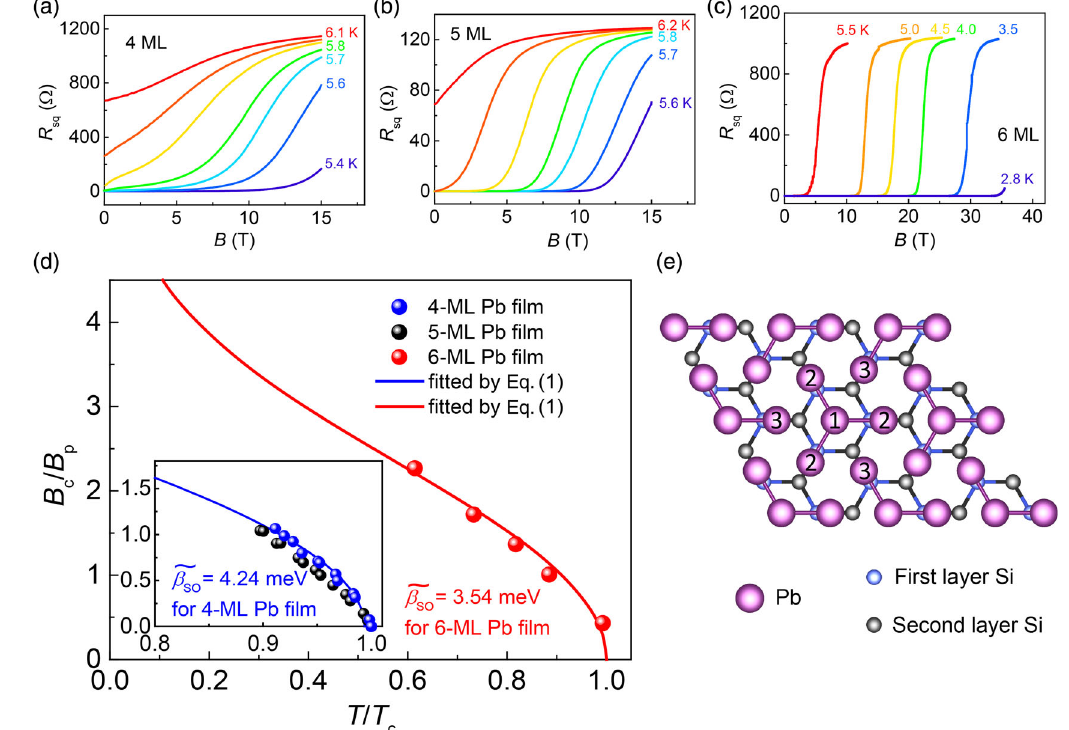
FIG. 3. Experimental evidence for Zeeman-protected superconductivity in ultrathin (4 – 6-ML) Pb films. (a) – (c) Parallel magnetic field dependence of R at various temperatures for (a) 4-ML (sample 1), (b) 5-ML (sample 2), and (c) 6-ML (sample 3) Pb films. At 2.8 K or sq lower temperatures, superconductivity survives under high magnetic fields up to 35.5 T for 6-ML Pb film. (d) B c normalized by Pauli limit B p as a function of reduced temperature T=T c for 6-ML Pb film. Here, B c is determined as the magnetic field required to reach 50% of normal-state sheet resistance R n . The measured B c can be well fitted by the theoretical curve for Zeeman-protected superconductivity ¼ 3 . 54 meV in 6-ML Pb film. Inset: Normalized critical field B =B [Eq. (1)], giving effective Zeeman-type SOI g β c p for 4-ML and SO ¼ 4 . 24 meV 5-ML Pb films measured in PPMS with magnetic fields up to 15 T. The blue line is a fitting curve using Eq. (1), giving g β SO in 4-ML Pb film. (e) The top view of the crystal structure of the SIC phase. Each unit cell consists of four Pb atoms, with three Pb atoms (marked as 2) forming a trimer and the other one (marked as 1) located at the center of the trimer. The distance between Pb1 and Pb3 (from the nearest unit cell) is much larger than that between Pb1 and Pb2, and the in-plane inversion symmetry is broken in this